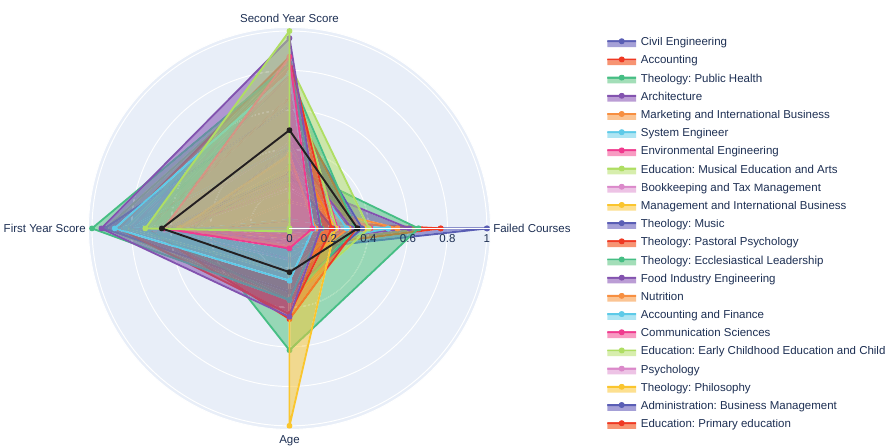
Figure 8. Principal factors by career. Distribution of the values of the most important attributes in the predictive model according to